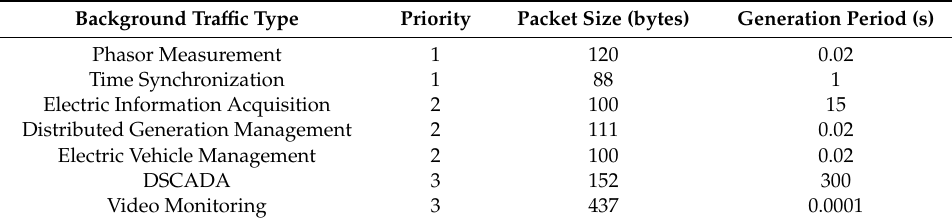
Table 2. Background traffic of the communication network.